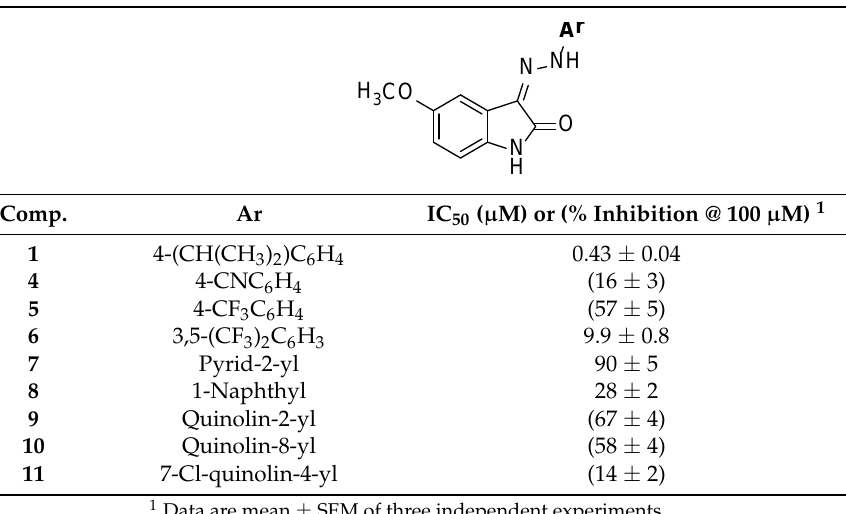
Table 1. A β Antiaggregating Activity of Compounds 1 and 4 – 11 .